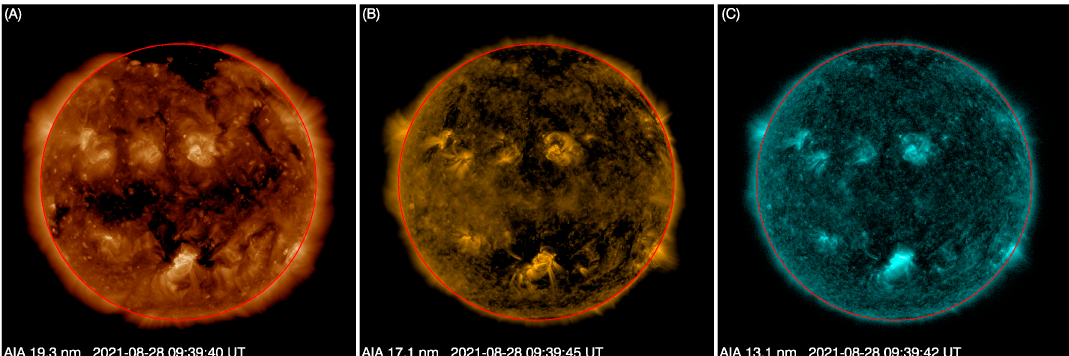
Figure 6. The calculated boundaries of the solar 19.3 nm ( A ), 17.1 nm ( B ), and 13.1 nm ( C ) images observed by AIA using the proposed method. The observation time is marked in the lower left corner of each image.